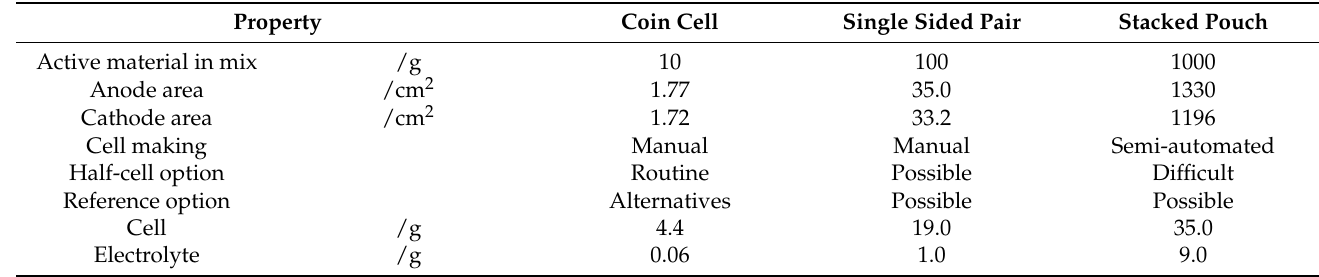
Table 1. Comparison of different cell